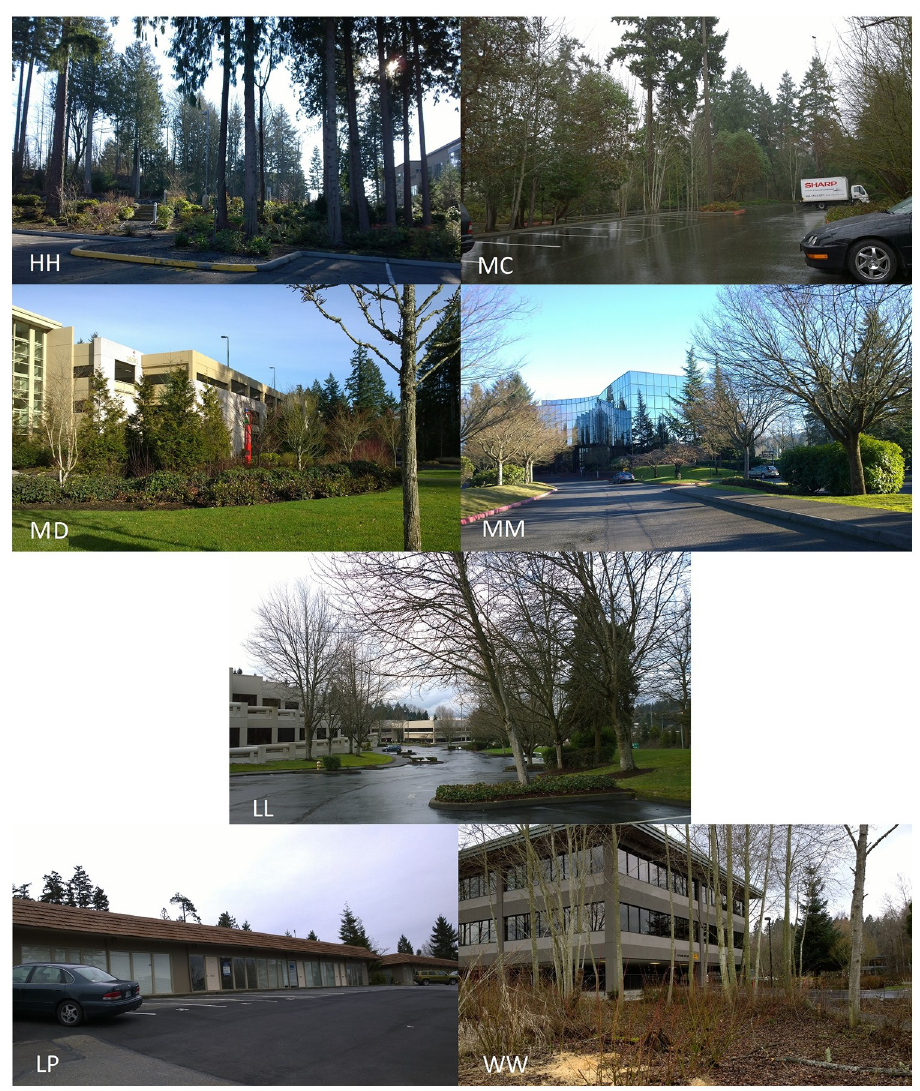
Fig 3. Examples of each vegetation type. From top left to bottom right: High (HH); Medium Canopy (MC); Medium Diverse (MD); Medium (MM); Low (LL); no vegetation (LP; excluded); wetlands (WW; excluded).